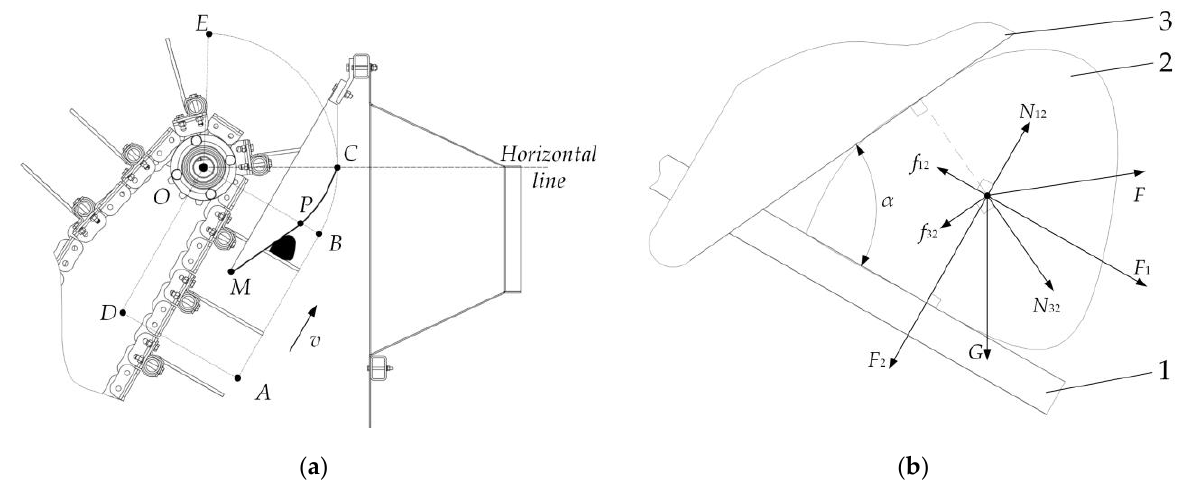
Figure 3. Analysis of the movement trajectory of the spring teeth and the force analysis of the RPF in the film-stripping process. ( a ) Motion trajectory of spring teeth in the process of film-stripping; ( b ) stress analysis of RPF during the film-stripping process. Note: 1, spring teeth; 2, RPF; 3, FTP.